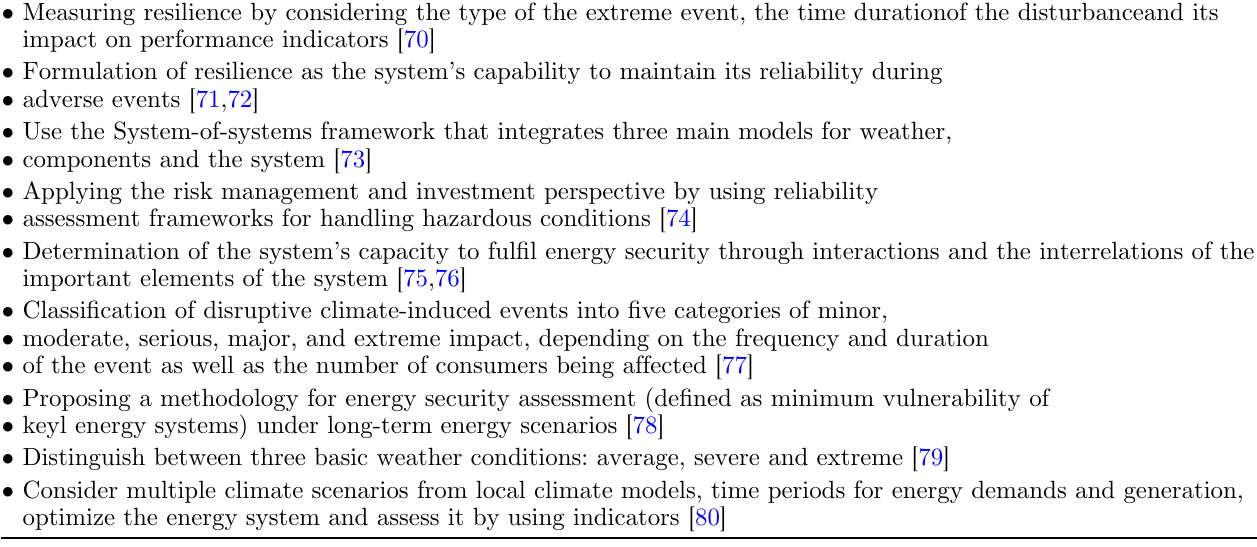
Table 5. Approaches for assessing the resilience of RES. (cid:129) Measuring resilience by considering the type of the extreme event, the time durationof the disturbanceand its impact on performance indicators